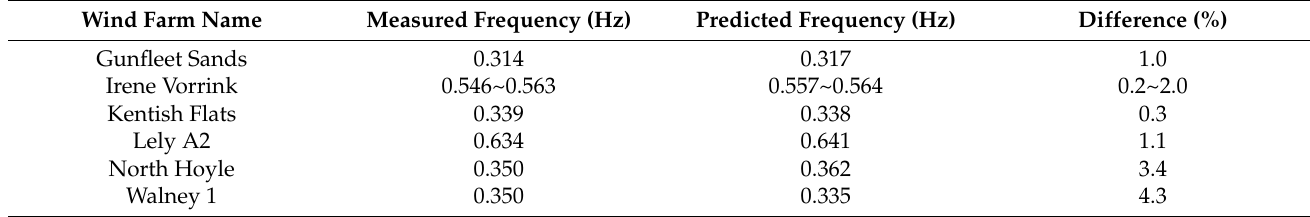
Table 3. Predicted and measured natural frequencies of all